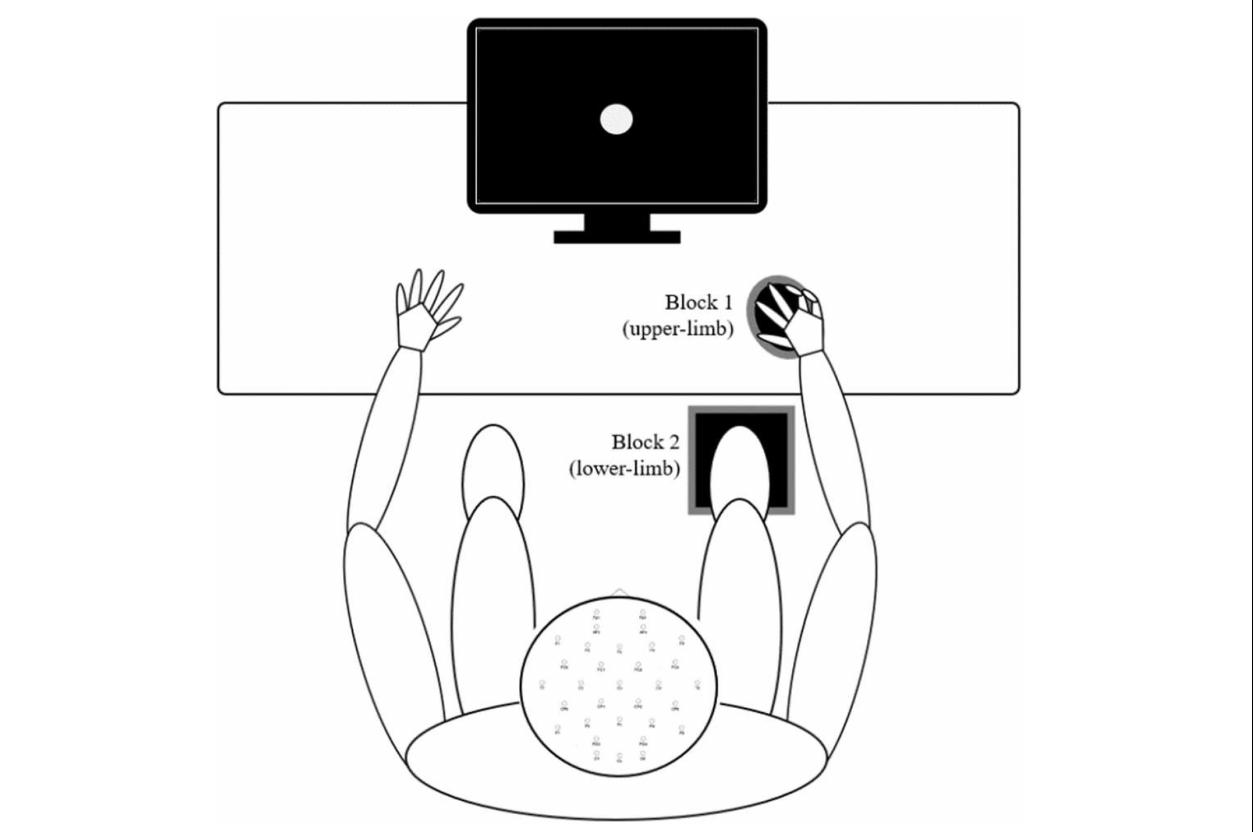
FIGURE 1 | Experimental procedures – Participants sat in a natural posture on a comfortable chair while maintaining visual fixation in the center of the screen in front of them. The two conditions (upper- and lower-limb) were applied in separate blocks, and the order of these blocks was randomized. In both conditions, the finger and foot rested on the response pad between responses.